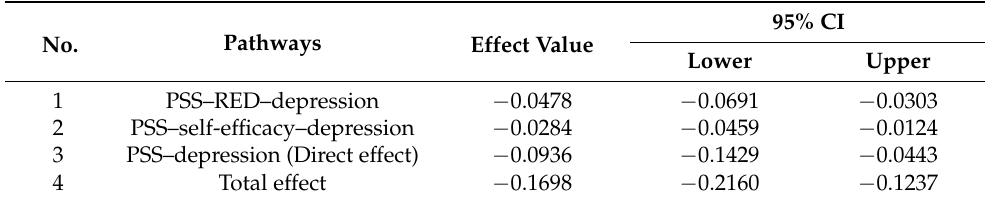
Table 3. Bootstrapping indirect, direct, and total effects and 95% confidence intervals for the media- tion